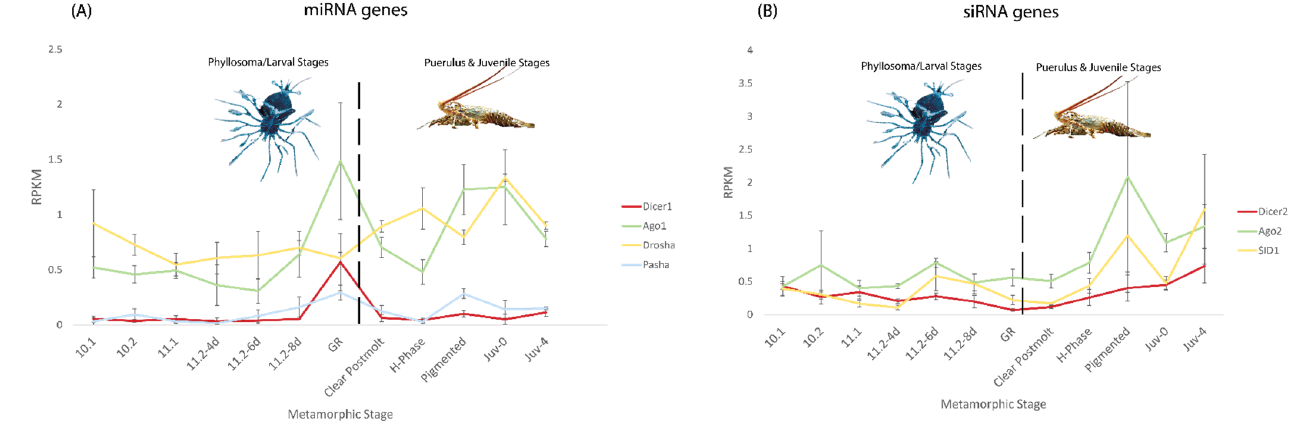
Figure 3. Micro RNA (miRNA) pathway ( A ) and small interfering RNA (siRNA) pathway ( B ) gene expression across metamorphic stages of the ornate lobster Panulirus ornatus (n = 3 for each stage). Gene expression is measured in reads per kilobase per million reads (RPKM), and stages left of the broken line (10.1, 10.2, 11.1, 11.2-4D, 11.2-6D, 11.2-8D, and gut retraction) represent the larval/phyllosoma stages, while those right of the broken line (clear postmolt, H-phase, pigmented, Juv-0, and Juv-4) represent the puerulus and juvenile stages. In ( A ) Dicer 1 is displayed in red, Argonaute 1 in green, Drosha in yellow, and Pasha in blue. In ( B ) Dicer 2 is displayed in red, Argonaute 2 in green, and SID1 in yellow.